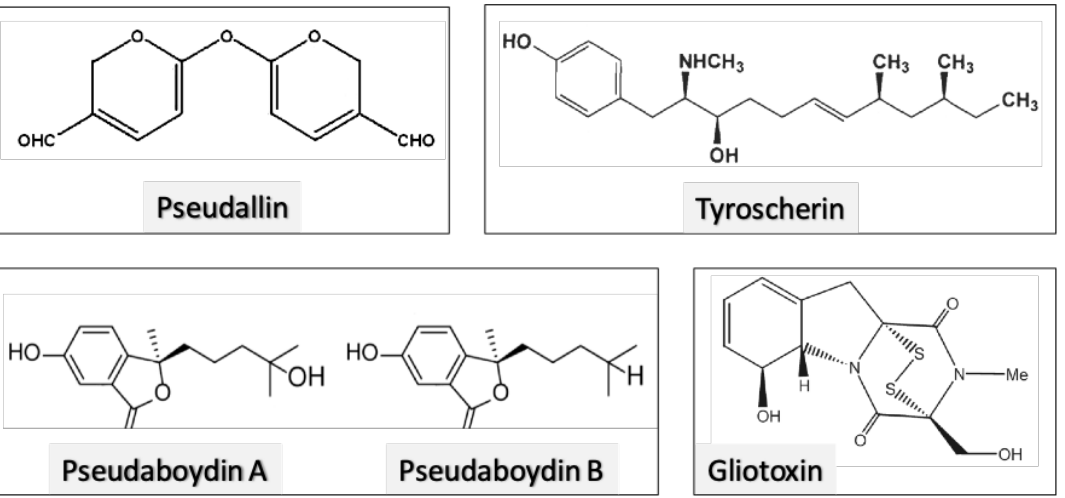
Figure 12. Some examples of non-peptide small-molecule metabolites extracellularly released by environmental and clinical strains of Scedosporium spp. Table 1. List of secondary metabolites identified in Scedosporium species and their potential biological